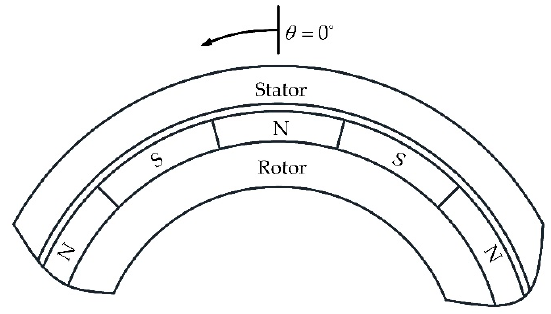
Figure 1. Simplified PMSM model.